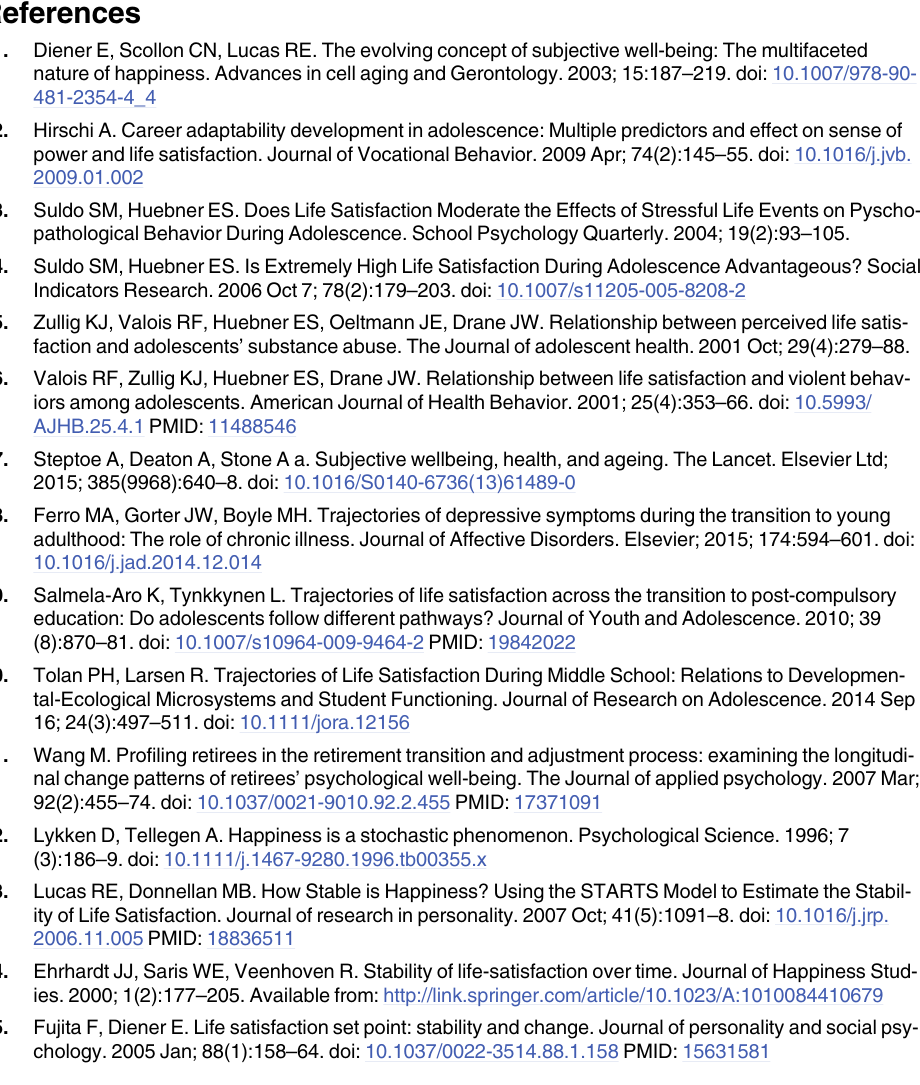
S6 Table. Transition Probability from Latent Profile Analysis. S7 Table. Demographics for each profile over